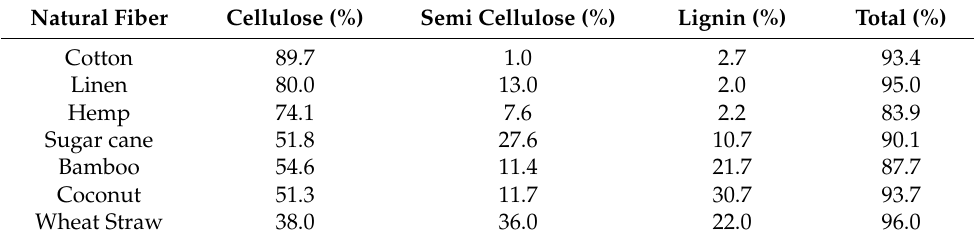
Table 1. Cellulose, semi cellulose and lignin contents in natural